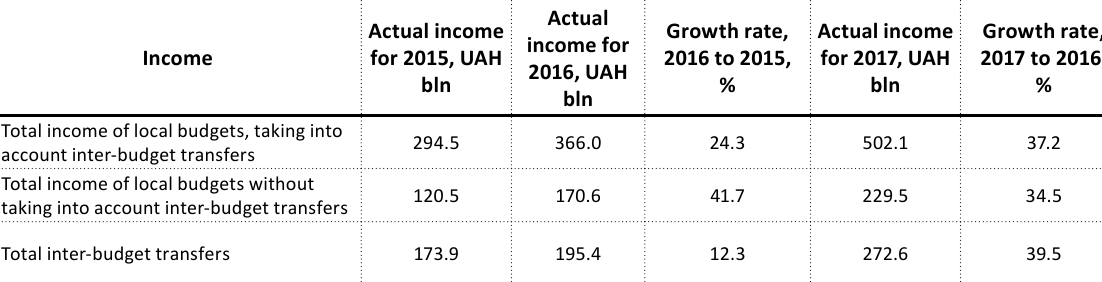
Table 2. Dynamics of income constituents of local budgets in